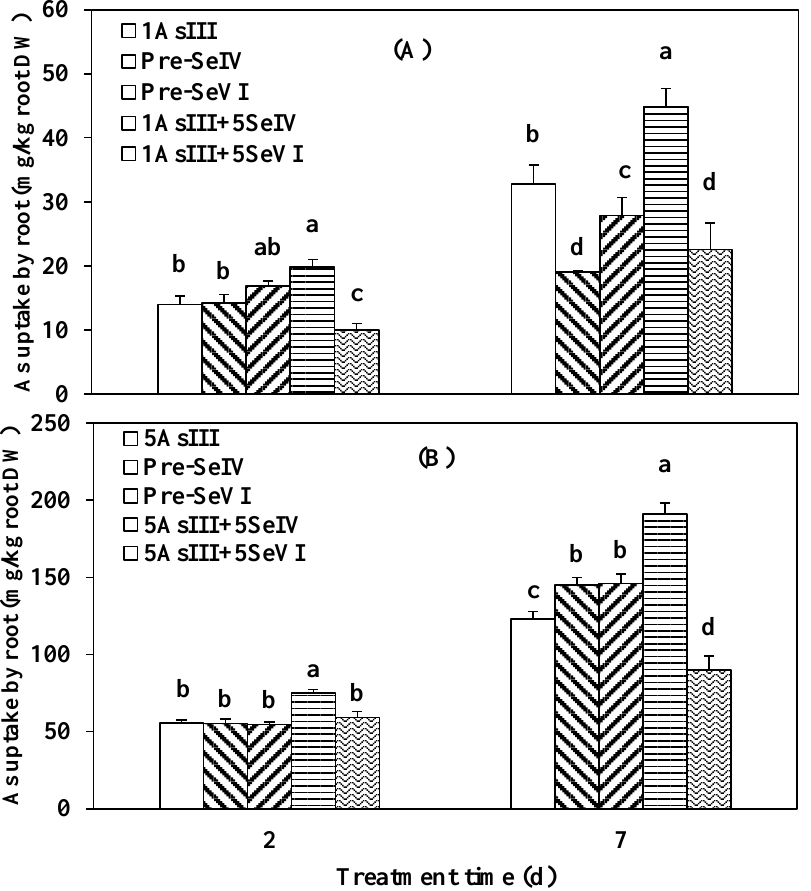
Figure 2. Effect of Se pre-treatment and co-application on As absorption by rice seedlings exposed to low ( A ) and high ( B ) As(III) levels. Data represent mean value ± SE (n = 3). Different letters indicate statistically significant ( p < 0.05) differences among treatments.